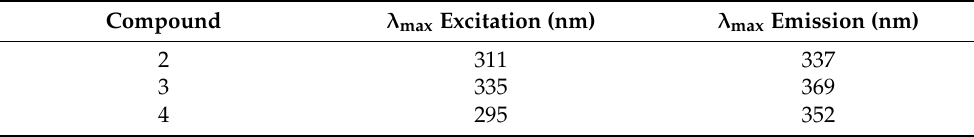
Table 4. The λ max values of excitation and emission for compounds 2 – 4